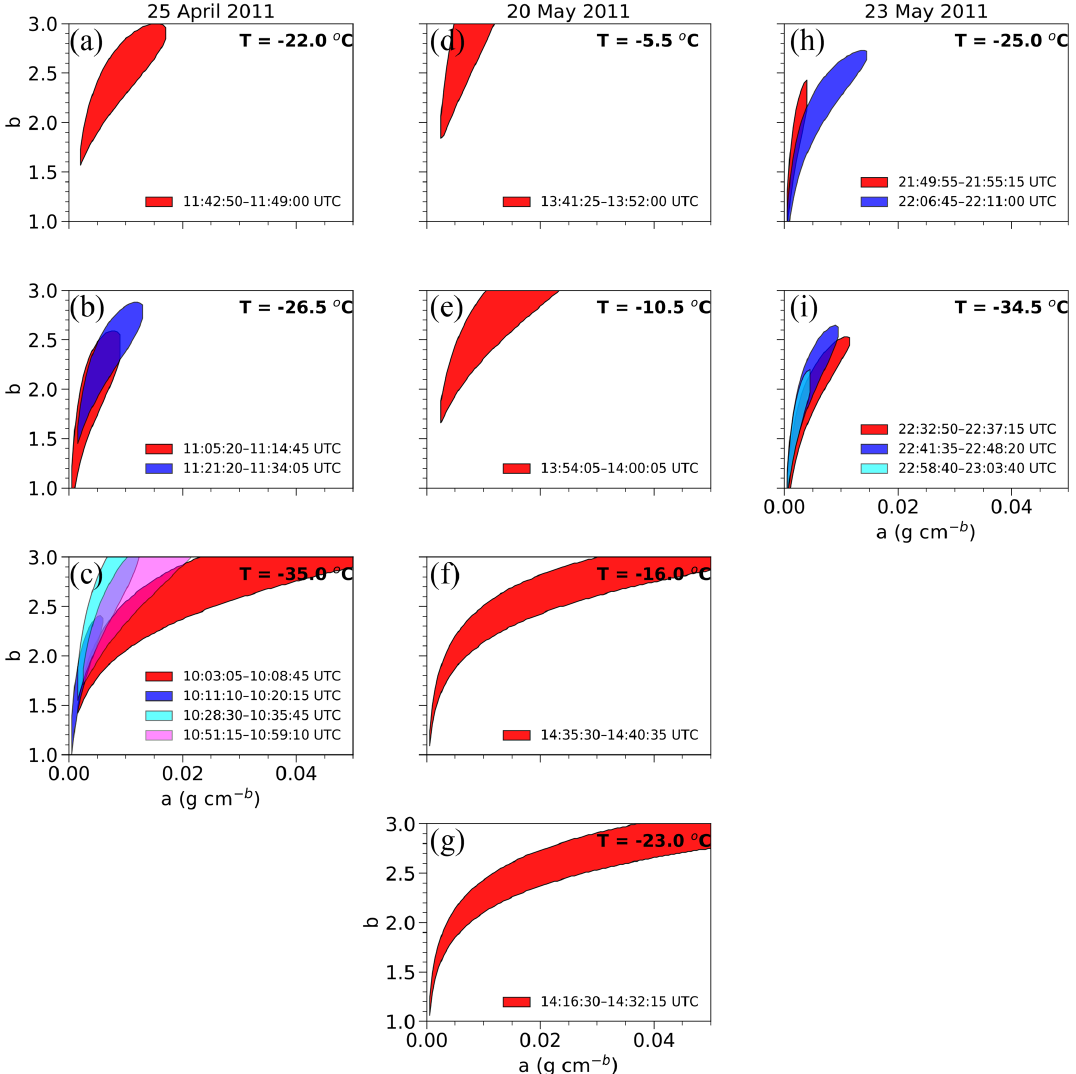
Figure 8. Surfaces of equally plausible a and b values for near-constant-temperature flight legs for (a–c) 25 April, (d–g) 20 May, and (h–i) 23 May 2011 events. Multiple legs occupying the same temperature are assigned a different color within a